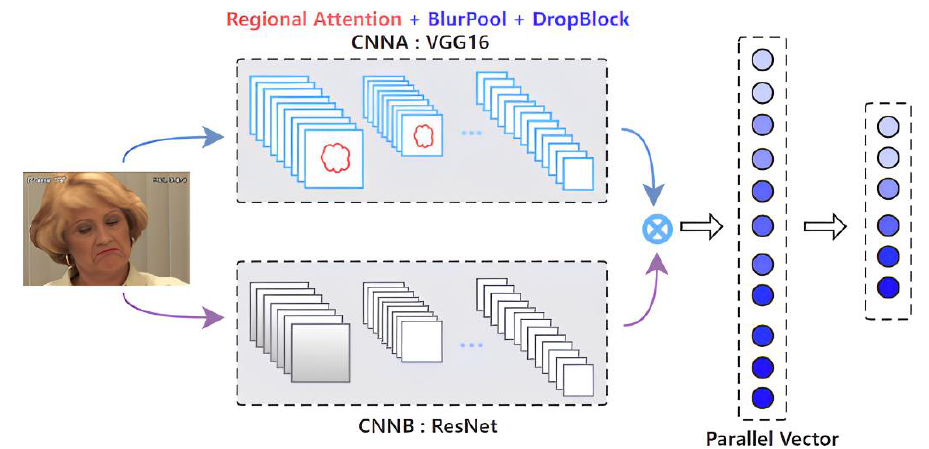
Figure 1. Block diagram of our proposed methodology.